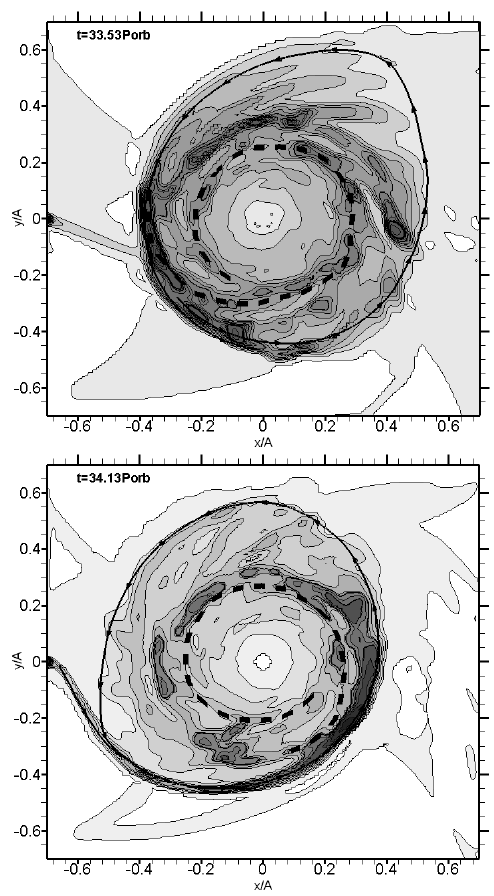
Figure 2: Pressure distributions in the equatorial plane of the system for two time moments τ = 33 . 53 P orb (top panel) and τ = 34 . 13 P orb (bottom panel). The black dashed line denotes the position of the preces- sional density